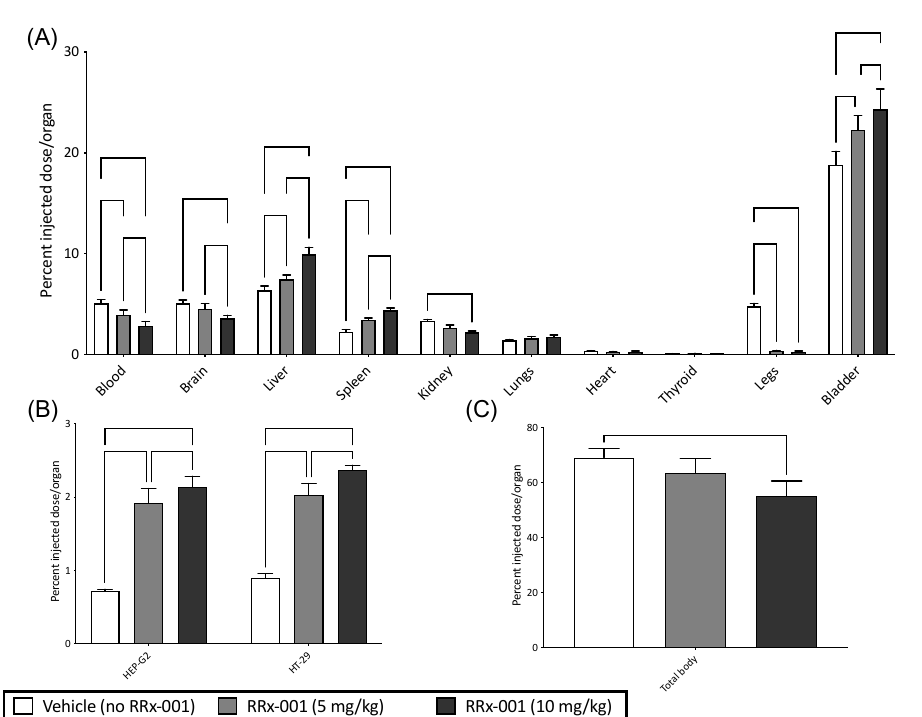
Figure 3. RRx-001 Treated RBCs Preferentially Localize to Solid Tumors. Shown here are percent injected dose/organ of 99m Tc labeled blood for ( A ) blood, brain, liver, spleen, kidney, lungs, heart, thyroid, legs, and bladder ( B ) HEP-G2 and HT-29, and ( C ) total body 99m Tc, for vehicle control (no RRx-001) and RRx-001 at concentrations of 5 and 10 mg/kg. (* p < 0.03, ** p < 0.002, **** p < 0.0001 for Holm-Sidak multiple comparisons ( B ) or Dunn’s multiple comparisons ( C )).